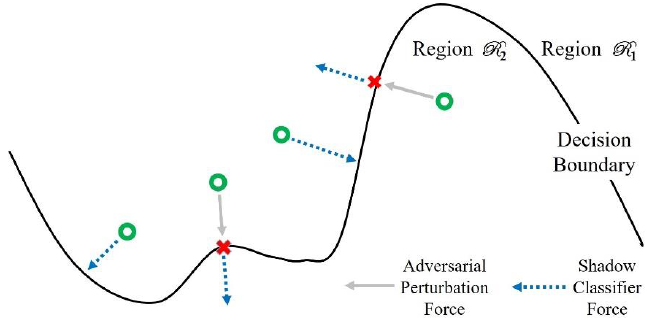
Figure 5. Schematic representation of how shadow classifier works in a two-dimensional (2D) example space. We depict normal and adversarial examples by green dots and red crosses, respectively.